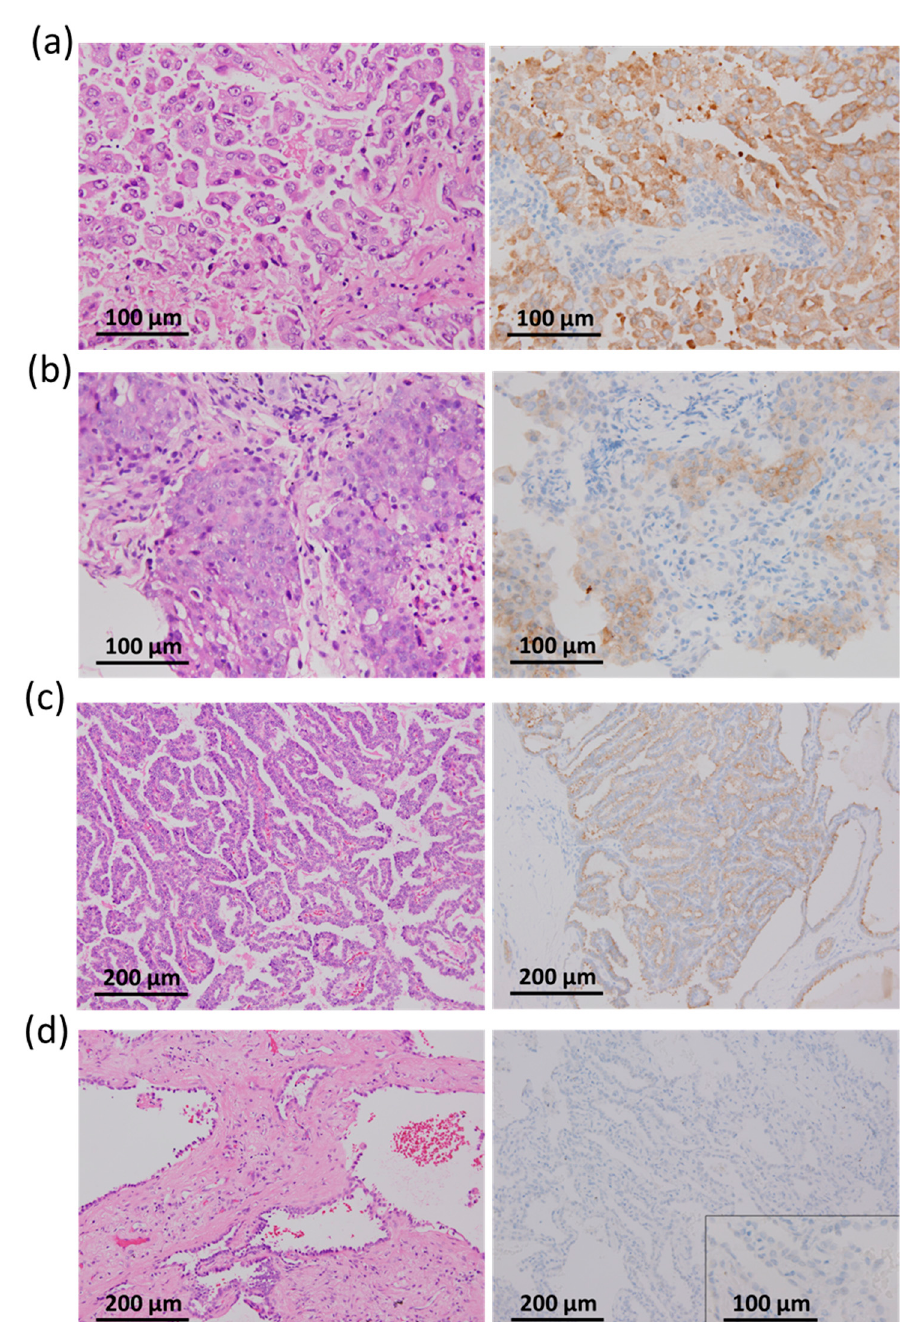
Figure 1. Pathological examination of lung adenocarcinoma with hematoxylin-eosin staining (left panels) and VE1 immunohistochemical staining (right panels). ( a ) A poorly differentiated (grade 3) micropapillary adenocarcinoma with strong cytoplasmic staining. ( b ) A poorly differentiated (grade 3) solid adenocarcinoma with moderate cytoplasmic staining. ( c ). A moderately differentiated (grade 2) papillary adenocarcinoma with weak cytoplasmic staining. ( d ). A moderately differentiated (grade 2), acinar adenocarcinoma carrying wild-type BRAF and no detected major driver gene alterations.